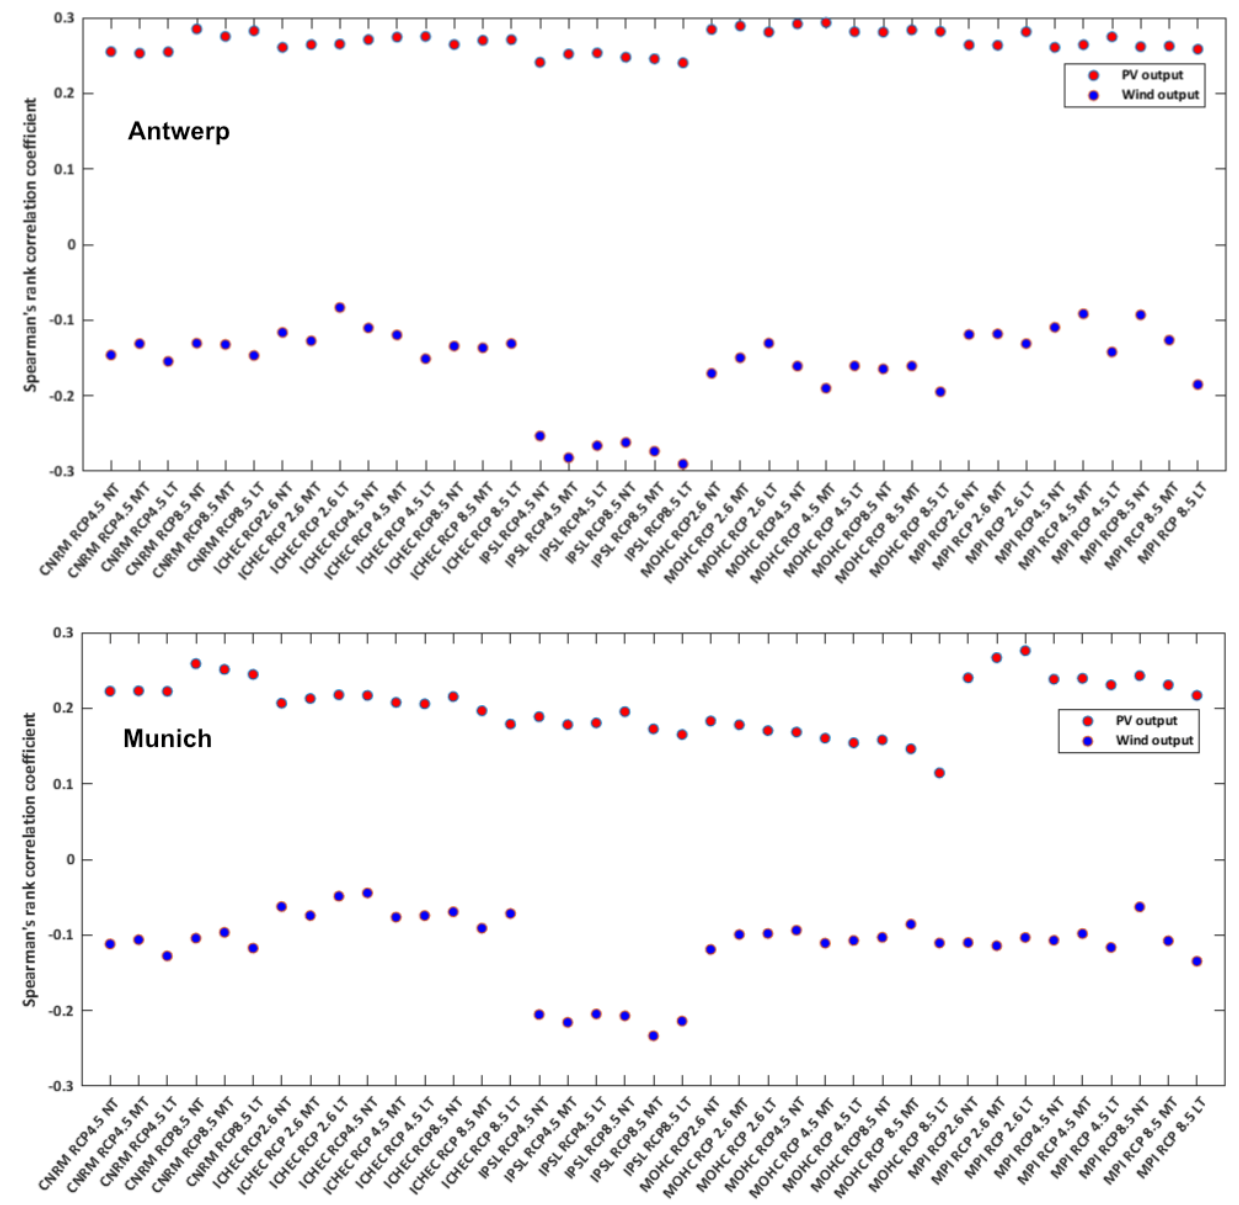
Figure 7. Spearman’s correlation between temperature and solar or wind output (Antwerp and Munich).